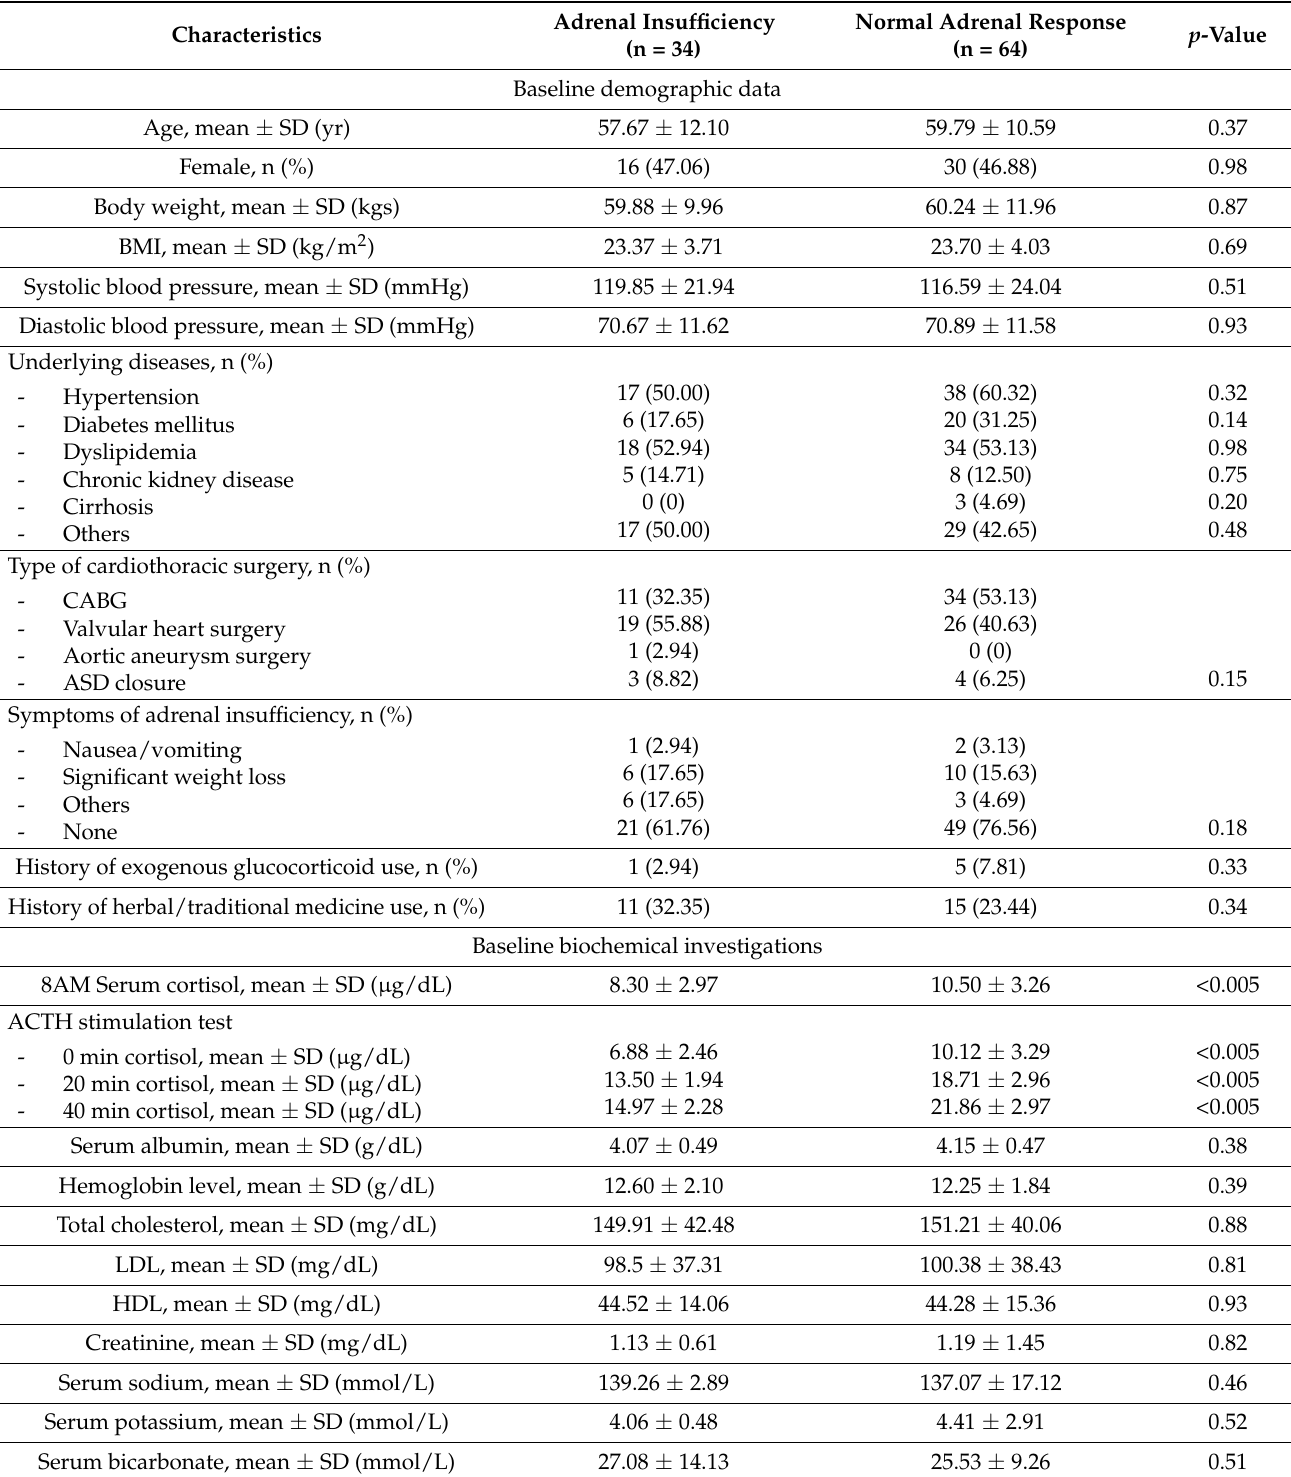
Table 1. Baseline